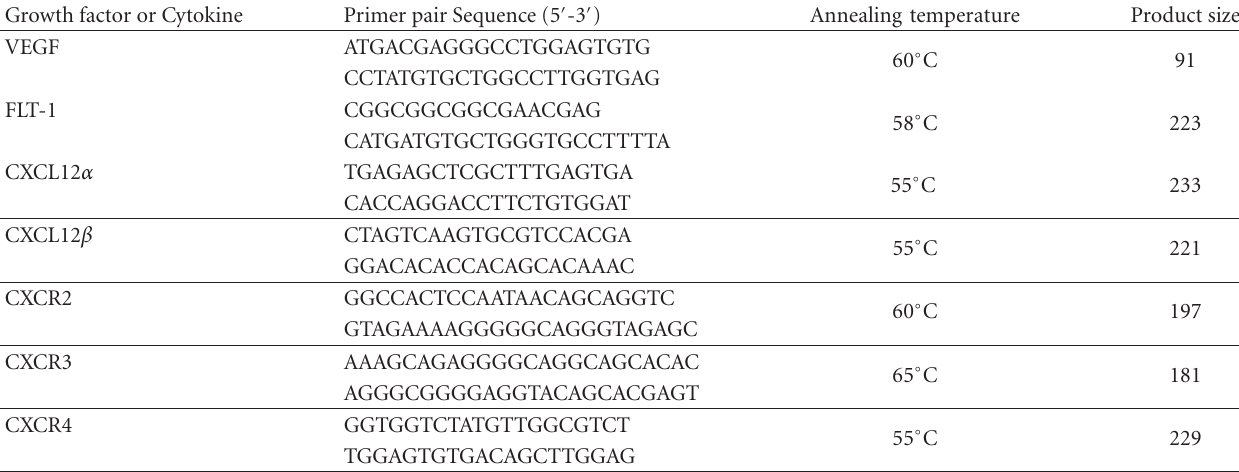
Table 2: Primer sequences used for quantitative Real-time RT-PCR.